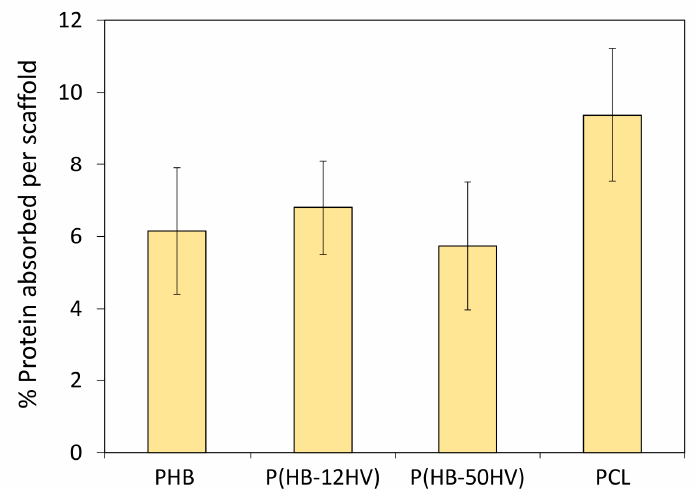
Figure 6. The adsorption of FBS proteins on 3D porous scaffolds. The values are the means with standard deviation derived from three independent scaffolds ( n = 3).